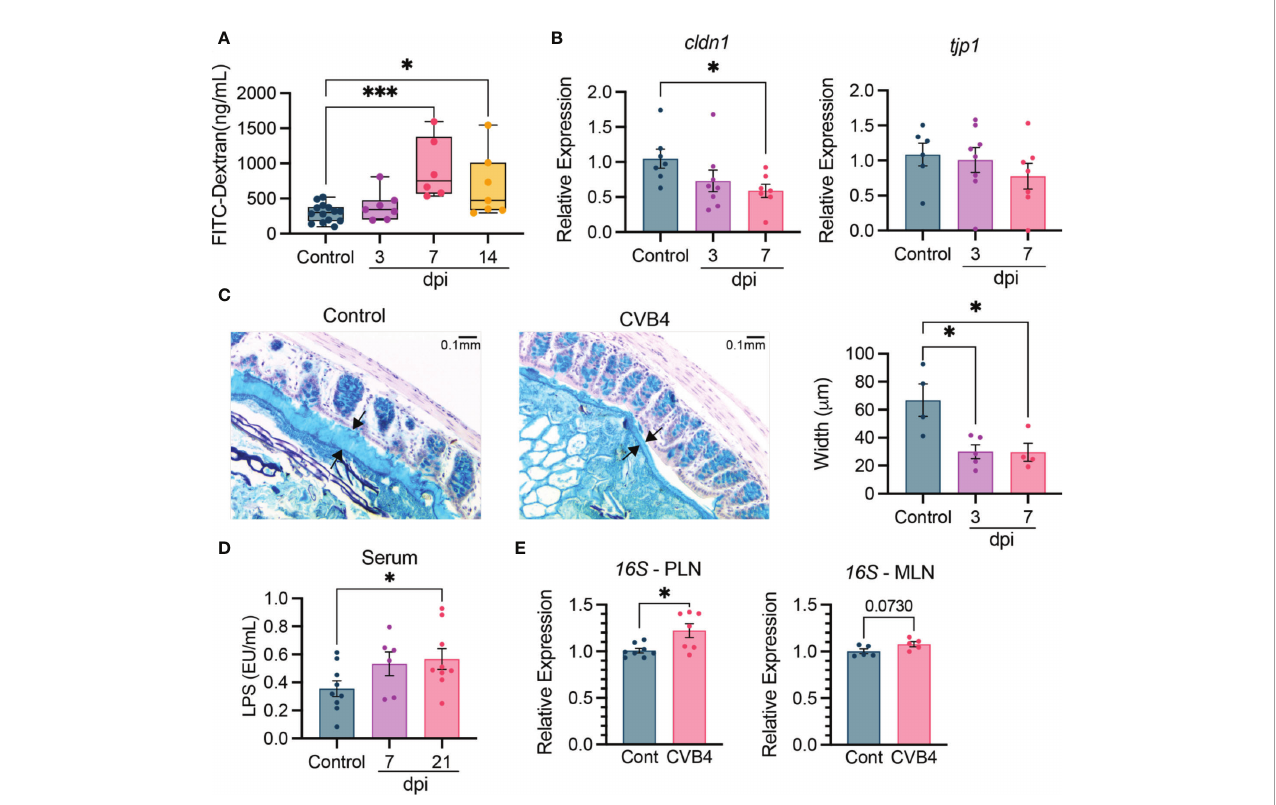
FIGURE 3 Altered intestinal physiology and bacterial translocation in CVB4-infected NOD mice NOD mice (11-12 weeks) were infected with 400 pfu CVB4 intra- peritoneally. (A) Intestinal permeability based on detection of orally gavaged FITC-Dextran (4 kD) in the serum. Data are combined from four independent experiments. (B) Gene expression levels of tight junction-related proteins claudin 1 and tight junction protein 1 in the proximal colon of naïve and CVB4- infected mice. Target gene expression was normalized to GAPDH and expressed relative to uninfected control mice. Data are combined from two independent experiments. (C) Representative images of Alcian Blue stained mucus (between arrows) from control and CVB4-infected mice (left) and quanti fi cation of mucus width (right). (D) LPS endotoxin levels in the serum. Samples collected from two independent experiments were run on single assay. (E) Detection of 16S rRNA in the MLN and PLN of control and CVB4-infected mice (day 7 pi) as determined by qPCR. Intestinal permeability is represented as median with range. All other results are expressed as the mean ± SEM. P values in A-D were calculated using Welch's ANOVA with Dunnet's T3 multiple comparisons test and E was calculated using paired Welch's r test (two-tailed). *P<0.05 was considered statistically signi fi cant; *** P ≤